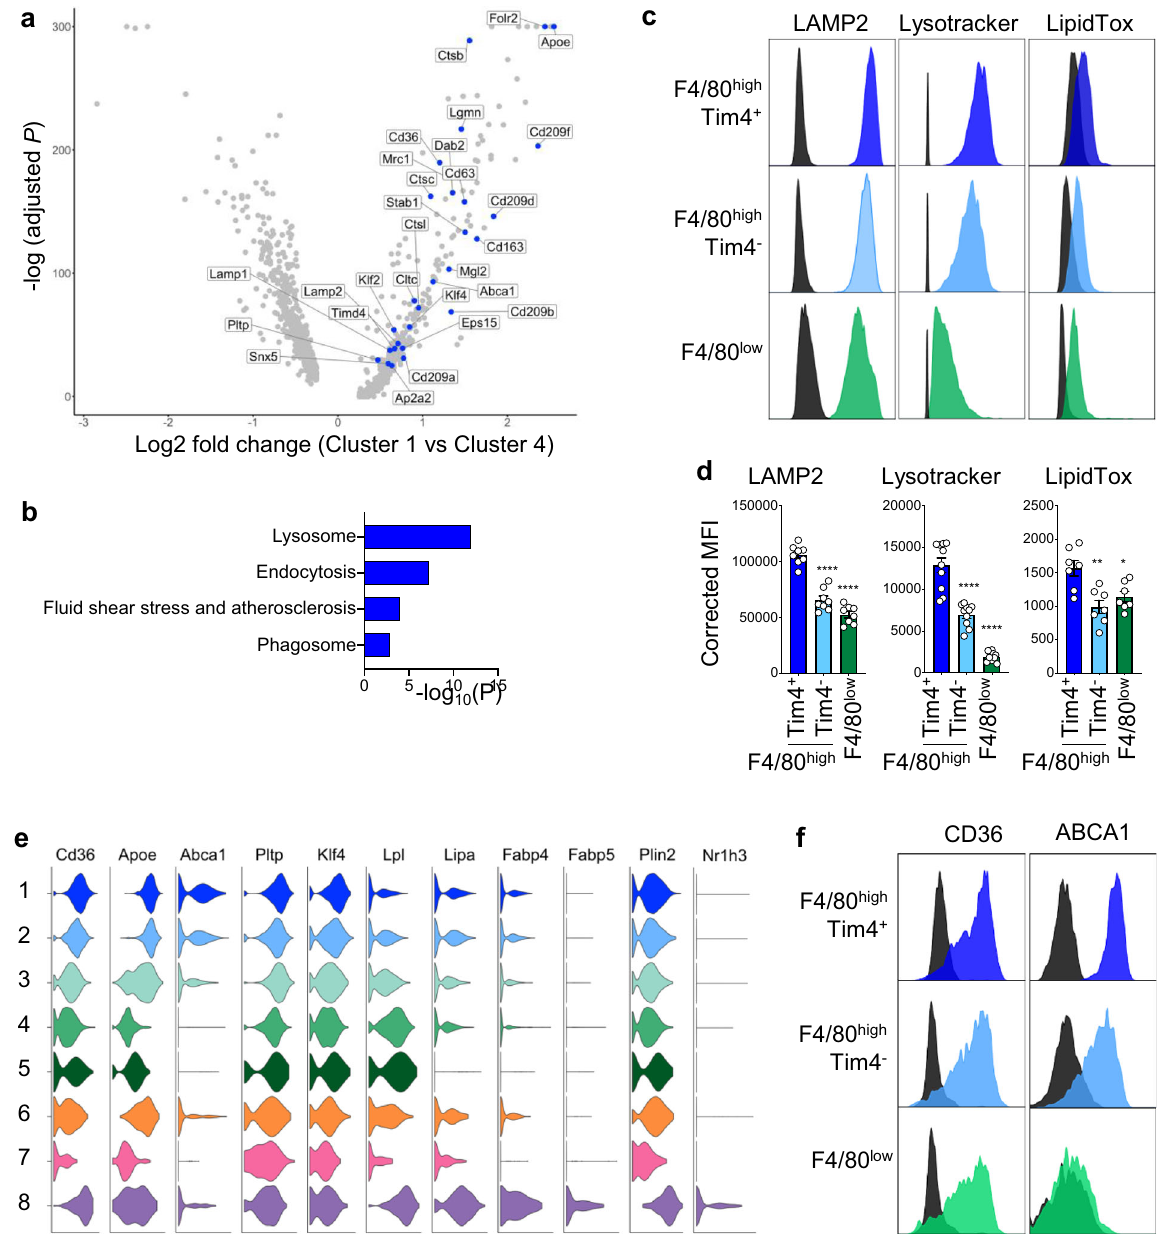
Fig. 3 Lyve1 + Tim4 + ATMs have high lysosomal and lipid content. a Volcano plot showing DEGs between Cluster 1 ( Lyve1 + resident ATMs) and Cluster 4 (BM-derived ATMs). Examples of DEGs distinguishing Cluster 1 are shown in blue. b KEGG pathway analysis on DEGs distinguishing Cluster 1. c , d Flow cytometric analysis on epididymal AT showing histogram of the fl uorescence intensity of LAMP2, lysotracker, and LipidTox in F4/80 high Tim4 + , F4/ 80 high Tim4 − , and F4/80 low ATM populations as gated in Fig. 2a with FMO in black ( c ) and quanti fi cation of mean fl uorescence intensity (MFI) for these staining on the indicated ATM populations ( d ). Data pooled from two independent experiments with n = 8 (LAMP2), n = 10 (lysotracker), or n = 7 (LipidTox) mice per group. Error bars show SEM. ANOVA with Sidak ’ s multiple comparisons test were applied after assessing normality using D ’ Agostino and Pearson Normality test. Signi fi cant differences are indicated by * P < 0.05, ** P < 0.01, **** P < 0.0001. e Violin plots by cluster of the expression of genes involved in lipid metabolism. f Flow cytometric analysis showing histogram of the fl uorescence intensity of CD36 and ABCA1 in ATM populations as de fi ned in c . Data representative of n = 7 mice per group in two independent Lyve1 + Tim4 + resident ATMs expressed high levels of Cd36 , a Eps15 , and Snx5 and phagocytosis such as Cd209a , Cd209b , Cd209f , Cd209d , Cd163 , Stab1 , Mrc1 , Timd4 , and Mgl2 (Fig. 3a, b receptor enabling the endocytosis of triacylglycerol-rich lipoprotein and Data fi le S2) 25 . Flow cytometric analysis of neutral lipid particles, similar to LAM (Fig. 3e). CD36 membrane expression content using LipidTox showed that Tim4 + Lyve1 + ATMs had a was con fi rmed by fl ow cytometry (Fig. 3f). Contrary to LAM higher neutral lipid content than F4/80 high Tim4 − and F4/80 low (Cluster 8), Lyve1 + resident ATMs (Cluster 1) did not show a transcriptional signature characteristic of TG metabolism and ATMs, suggesting that Tim4 + Lyve1 + ATMs were invo displayed low expression of Lpl and Lipa , which catalyze the lved in lipid uptake and metabolism at steady state lipolysis of TG, as well as low expression of Fabp4 and Fabp5 , (Fig. 3c, d).